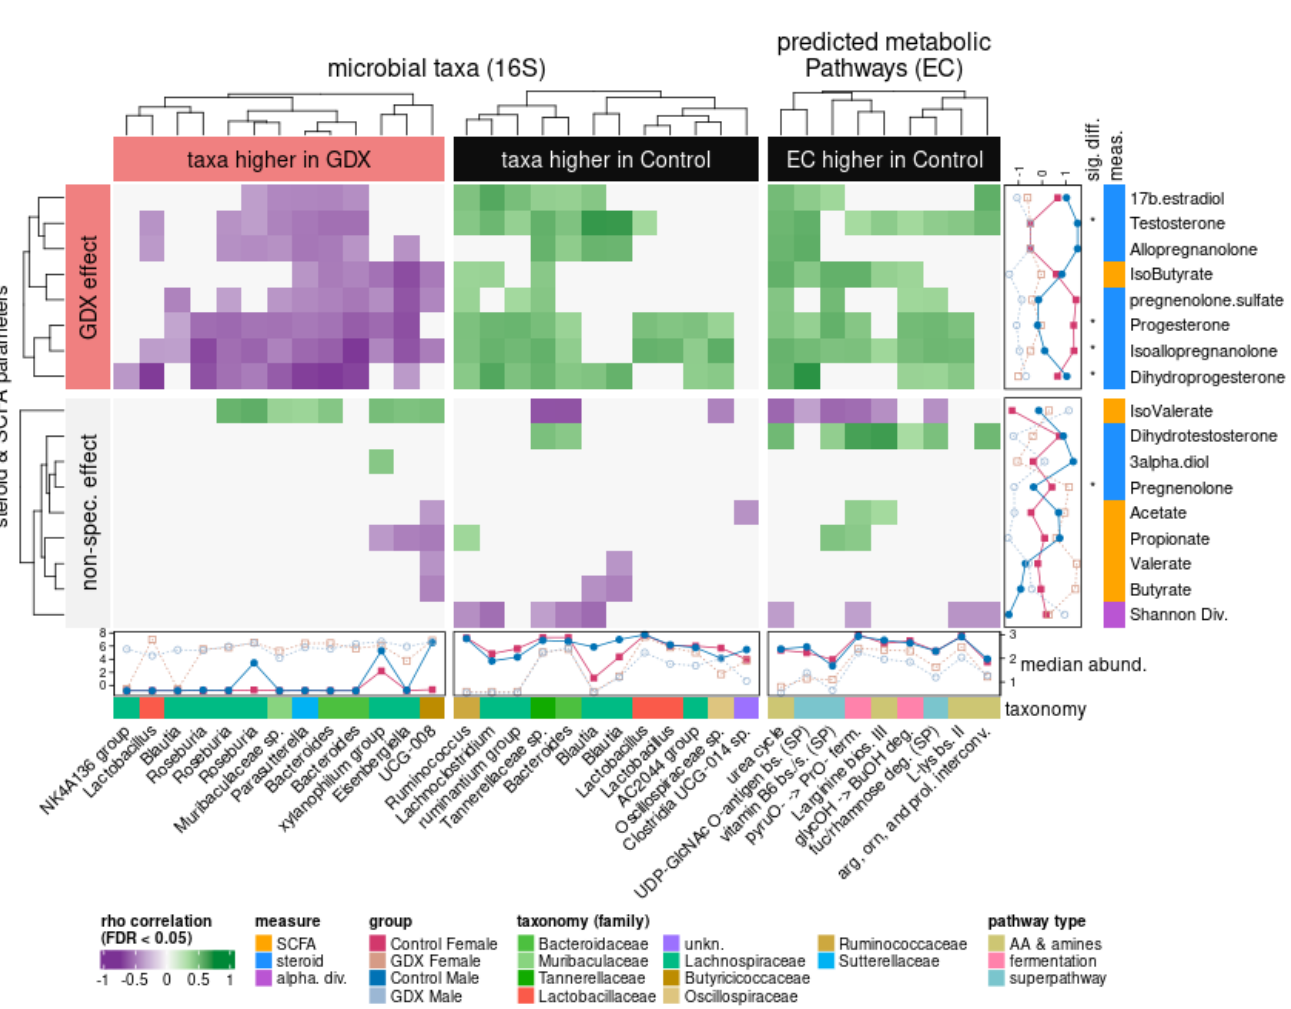
Figure 7. Microbiome features associated with control are positively correlated (green) with an abundance of multiple steroids. This also extends to predicted metabolism, which only shows positive correlations with steroid levels; many of these steroids are also significantly more abundant in the control rats (*, Figure 2). This unified pattern suggests that the control gut microbiome metabolizes a range of host steroids and is negatively affected when these substrates are depleted by gonadectomy. Disruption via GDX favours an alternate cohort of bacteria, but it does not foster new predicted metabolic activities. Heatmap: colours reflect positive (green) or negative (purple) Spearman’s ρ correlations between microbial features (ASVs, predicted ECPs and biological parameters: steroids, fatty acids, Shannon’s alpha diversity). Top row (GDX effect): summarizes associations relevant to experimental design; bottom row (non-spec. effect): summarizes incidental associations which do not cluster with the main experimental effect. Right-hand margin: unit-scaled abundances, significant differences if applicable (*), and categories for biological parameters in this study (steroid, fatty acids, alpha diversity). Bottom margin: scaled abundances, and microbial taxonomy (ASVs) or pathway types (ECPs) of features. All microbial features (ASV, EC) shown here were found to differ significantly between control and GDX (FDR < 0.05).